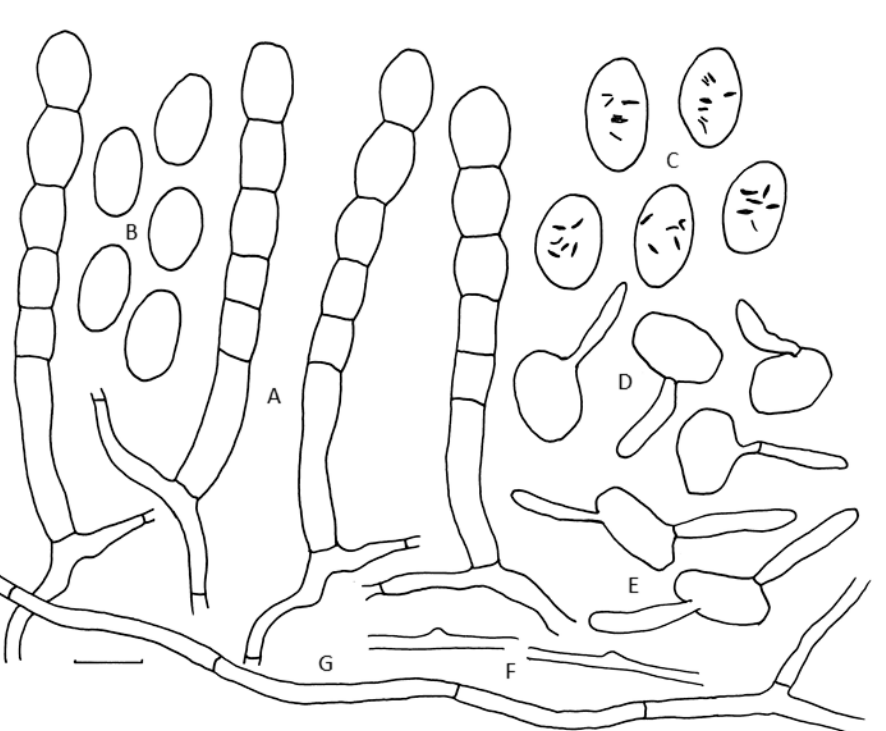
Figure 4. Podosphaera cunningtonii on Prunus persica morphology. ( A ) Conidiophores on Sellotape strip in lactic acid. ( B ) Conidia (mounted in lactofuchsin). ( C ) Conidia (mounted in water), showing fibrosin bodies. ( D ) Conidia germinated on host leaf for 24 h (mounted in lactofuchsin). ( E ) Conidia germinated on host leaf for 48 h (mounted in lactofuchsin). ( F ) Inconspicuous, nipple-shaped appressoria (mounted in lactofuchsin). ( G ) Hyphae on Sellotape strip (mounted in lactofuchsin). Scale bar = 20 µm. (All drawings from holotype VPRI 19591, except D & E from VPRI 20705).